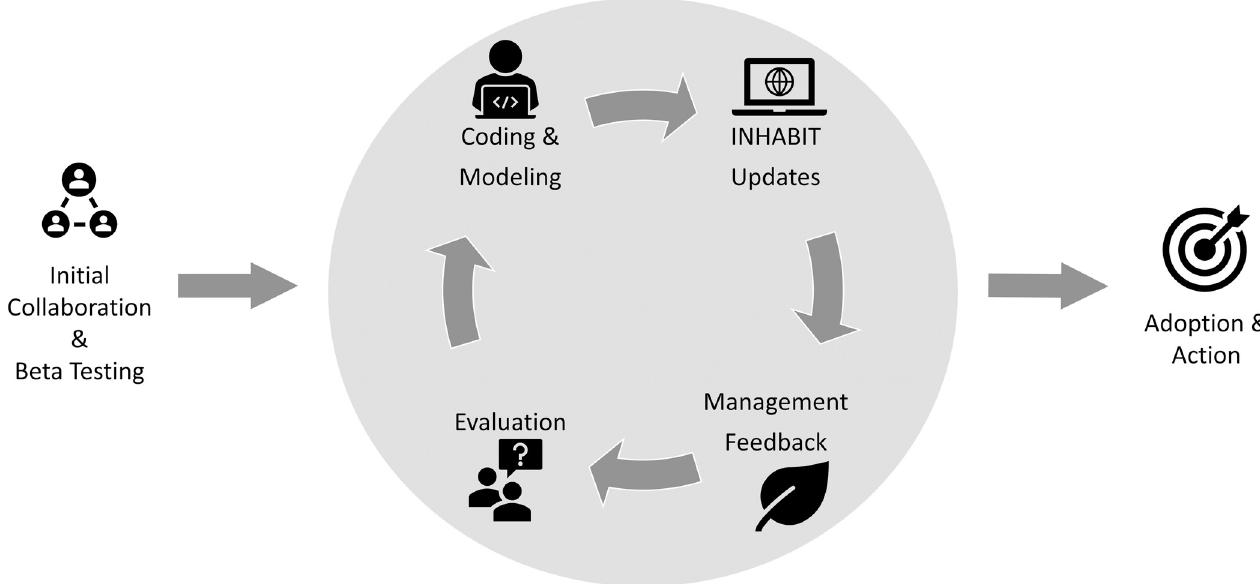
Fig 1. A conceptual diagram illustrating the development of the Invasive Species Habitat Tool (INHABIT). Co-production starts on the left and follows through to eventual adoption and land management or policy actions. The grey middle circle denotes the iterative cycle where updates are made to species distribution models and user interface